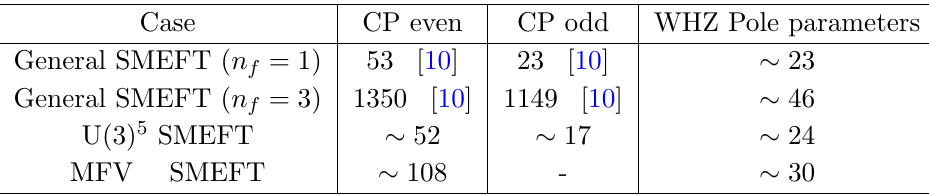
Table 1 . Parameter counts in the general SMEFT (cid:13)avour cases for n f generations, and the approximate number of parameters that feed into a W-Higgs-Z pole parameter program in the Warsaw basis, as discussed in section 10. Also shown are the parameter counts in the U(3) 5 limit and the MFV SMEFT case. The symbol indicates that these latter results are approximate (cid:24) counts for a leading order analysis, with leading (cid:13)avour breaking spurion insertions, as discussed in section